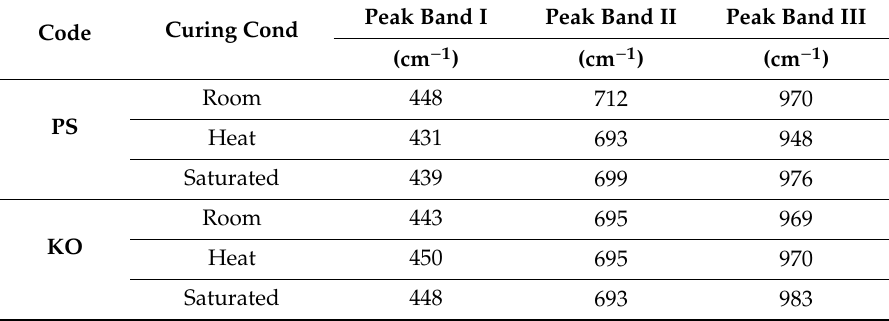
Table 5. Location of main IR peaks in PS and KO